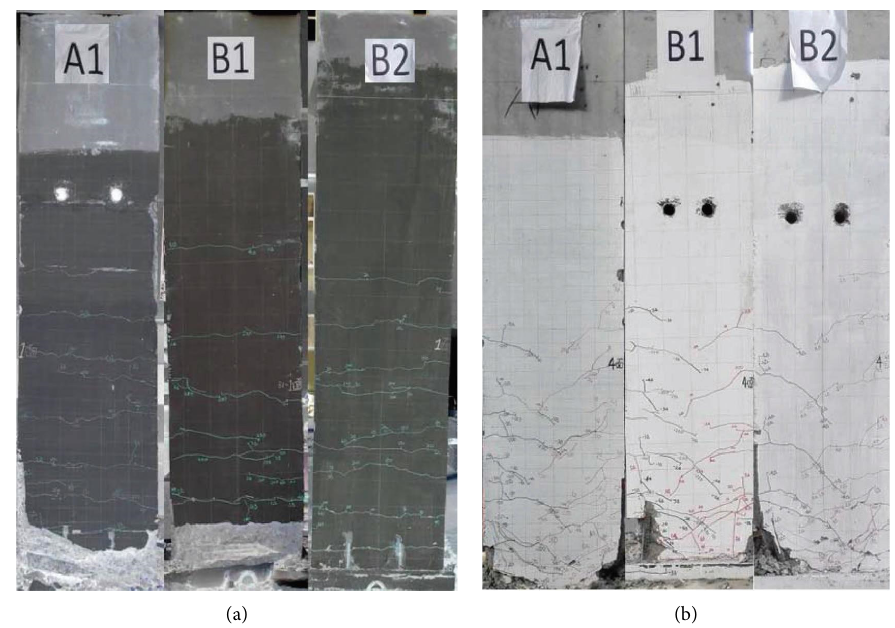
Figure 5: Distribution of cracks in pier columns. (a) Loading surface. (b) Side